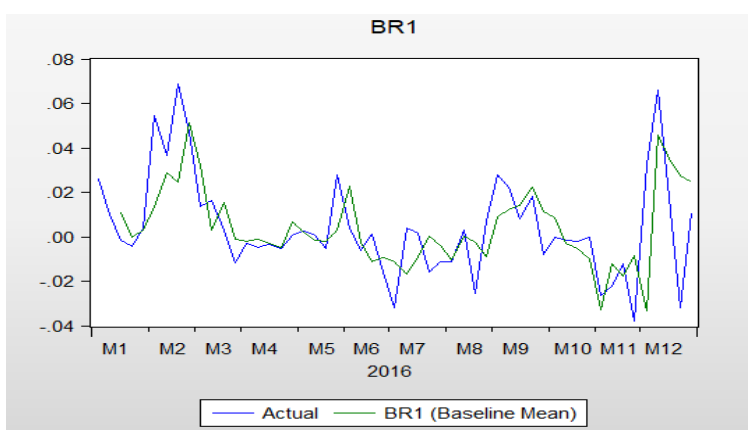
Figure 2. out-of-Sample Prediction for Stock